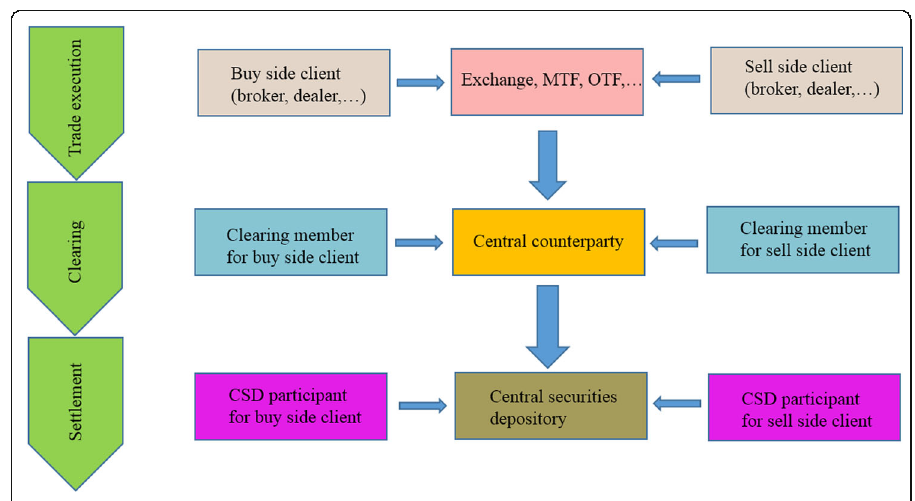
Fig. 2 A simplified representation of the security leg of the trade life